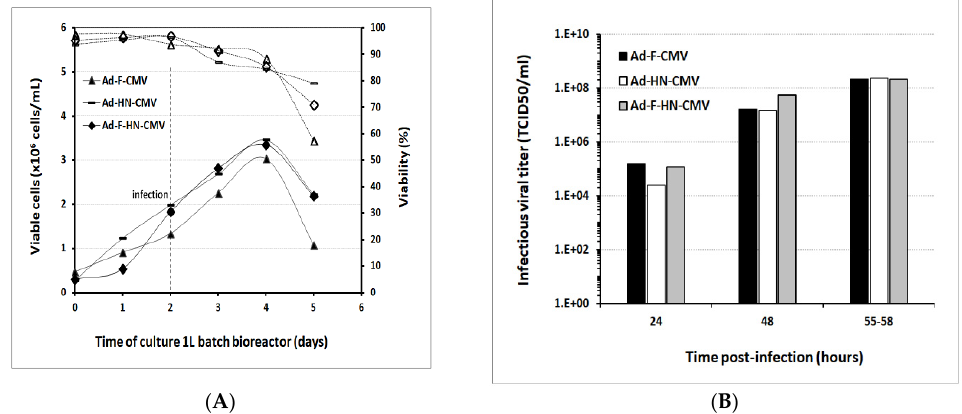
Figure 4. Adenoviral vector production in 1L controlled bioreactors operated in batch mode: ( A ) Time course of viable cell growth and cell viability during the production of the three recombinant adenoviral vectors encoding the F, HN, and F-HN antigens from NDV under the regulation of the